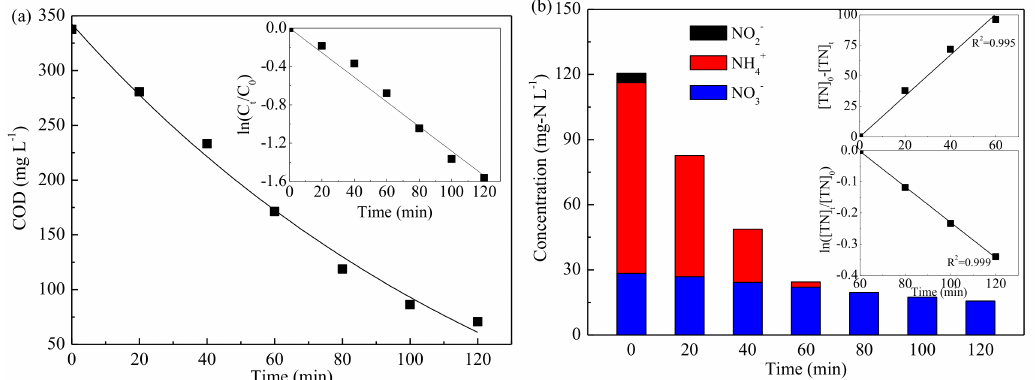
Figure 7. The simultaneous removal of COD ( a ) and total nitrogen ( b ) in actual pharmaceutical wastewater